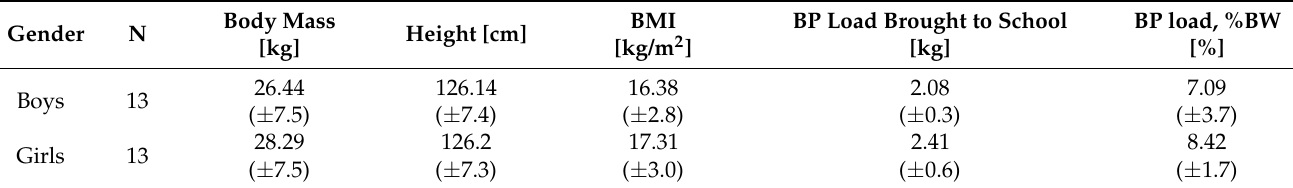
Table 1. Participants’ anthropometrics and BP loads (mean ±